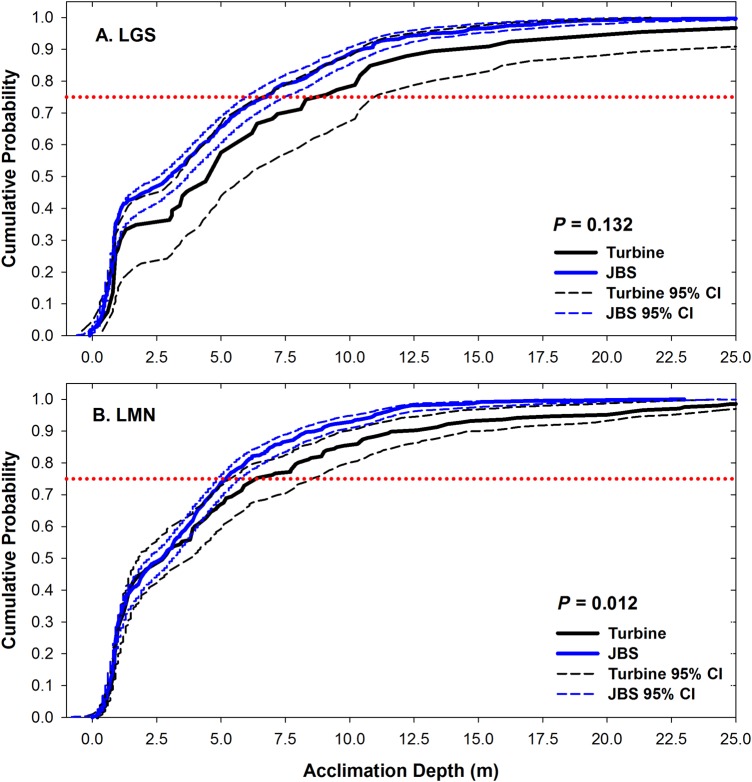
(A) A comparison of depth distributions of yearling Chinook salmon implanted with acoustic transmitters during 2012 passing Little Goose Dam (LGS) through either the turbines or the juvenile bypass system (JBS). There was no significant (P ≥ 0.05) difference in the depth distributions of JBS- and turbine-passed fish. (B) A comparison of depth distributions of yearling Chinook salmon implanted with acoustic transmitters during 2012 passing Lower Monumental Dam (LMN) through either the turbines or the JBS. There was a significant difference (P < 0.05) in the depth distribution of JBS and turbine-passed fish. The 95% confidence intervals (CIs) for each depth distribution are included. The dotted horizontal red line indicates that 75% of the fish were residing at or shallower than the corresponding depth.